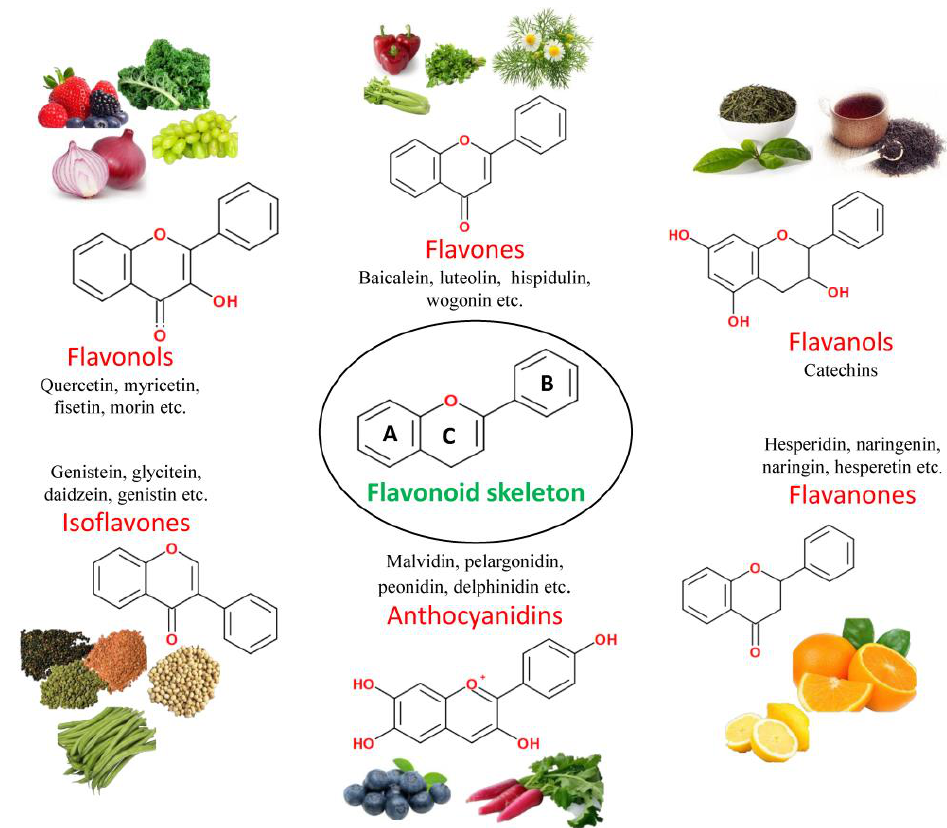
Figure 2. Structure and classification of flavonoids and their dietary sources.